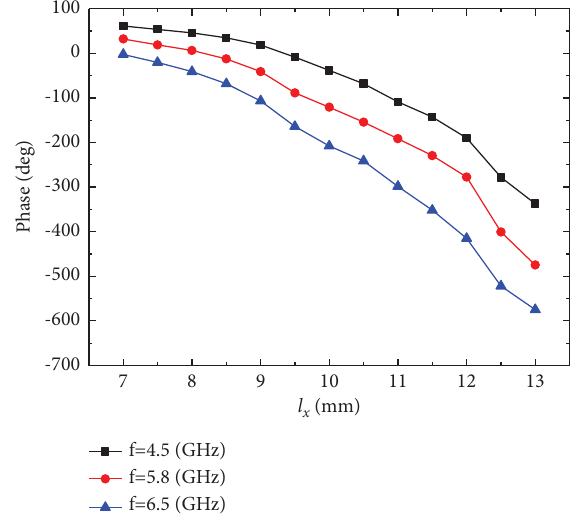
Figure 3: Refected phase characteristic